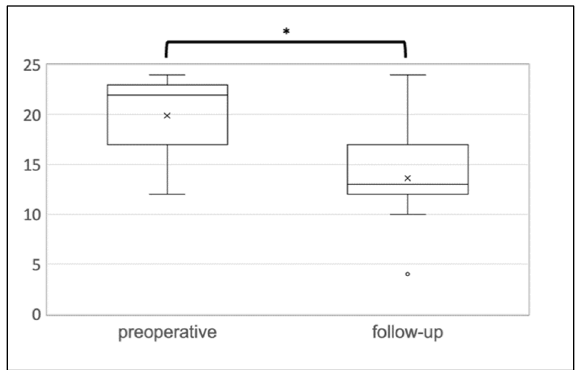
Figure 2. St. Mark’s incontinence score. The median St. Mark’s incontinence score decreased from 22 to 13 points ( p = 0.008). * = significant; x = mean; ° = statistical outlier outside 1.5 times interquartile range.